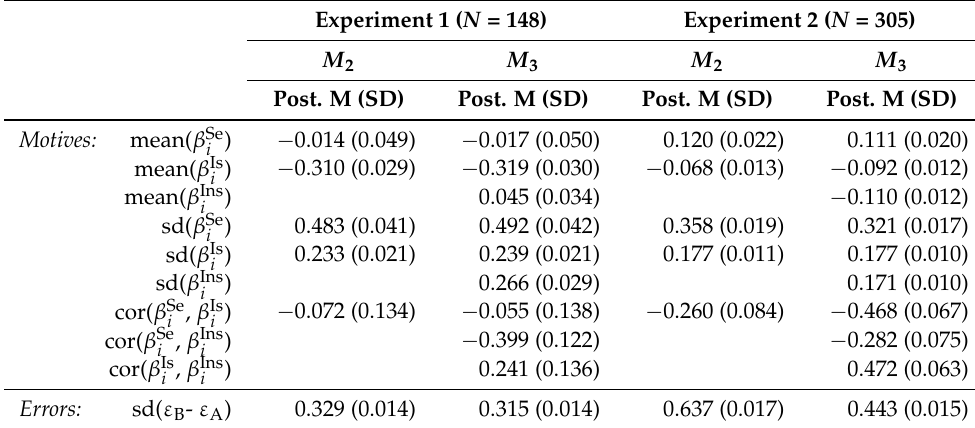
Table 7. Posterior estimates of the population distribution of social